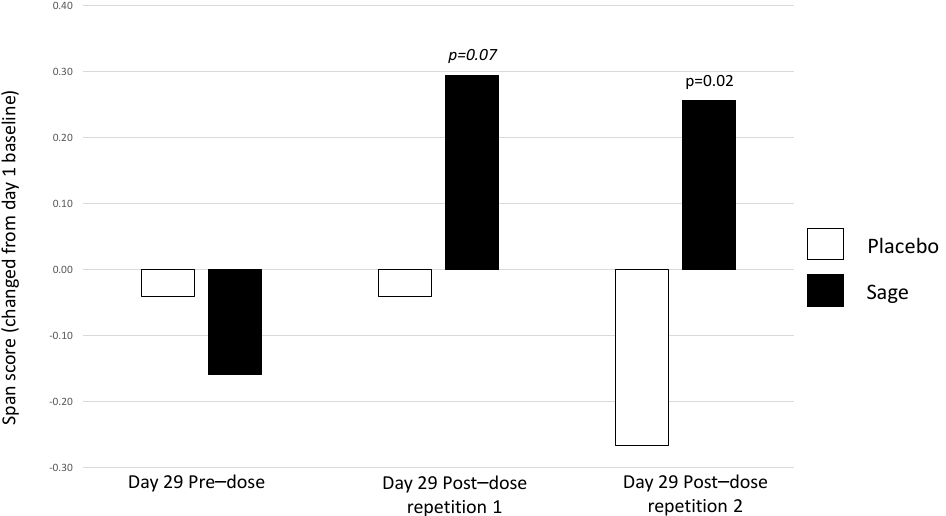
Figure 8. Pure chronic interaction between treatment × repetition on Corsi blocks span score: a significant pure chronic interaction between treatment × repetition ( p = 0.001) was observed, and here, when compared to day 1 baseline performance, the post-dose repetition 1 span score trended ( p = 0.07) towards being significantly better in the sage condition than the placebo and was significantly better at post-dose repetition 2 ( p = 0.02). Of the 5 global cognitive domains that can be derived from combining COMPASS task outcome measures, 2 evinced significant effects pertaining to